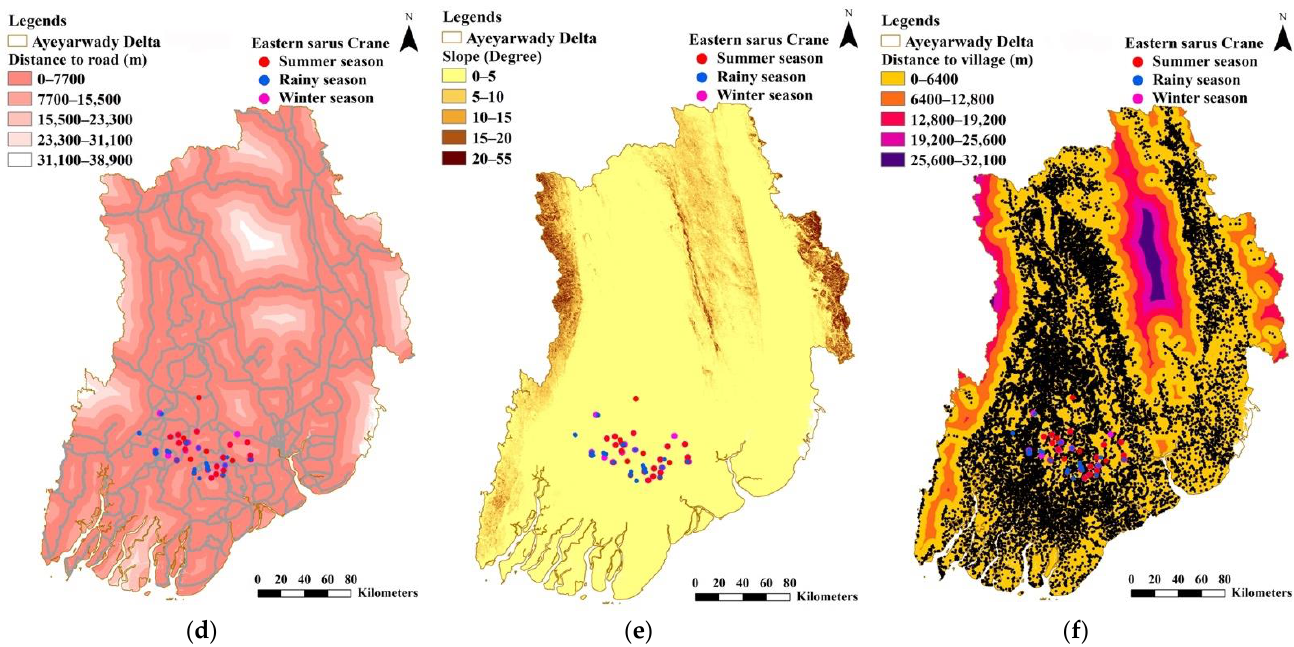
Figure 3. Geographic parameters used to create the distribution model of eastern sarus crane ( Antigone antigone sharpii ) in Ayeyarwady Delta, the Union of Myanmar; ( a ) elevation, ( b ) land cover, ( c ) distance to river, ( d ) distance to road, ( e ) slope, and ( f ) distance to village.